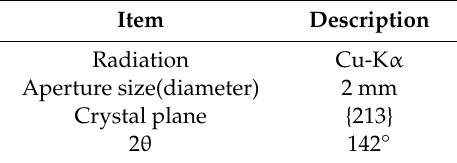
Table 5. XRD parameters during residual stress measurement.